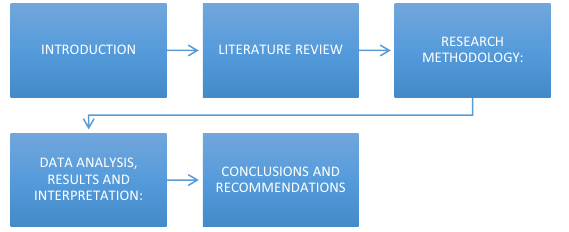
Figure 1. Structure of study